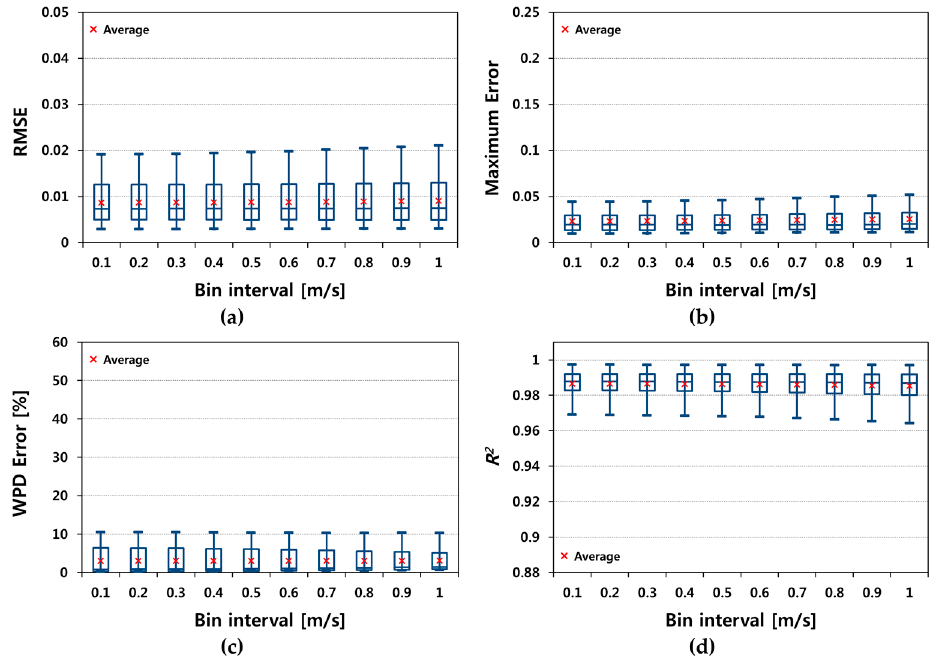
Figure 4. The results of the accuracy tests according to bin interval (MMLM). ( a ) RMSE; ( b ) Maximum error; ( c ) WPD error; ( d ) R 2 .